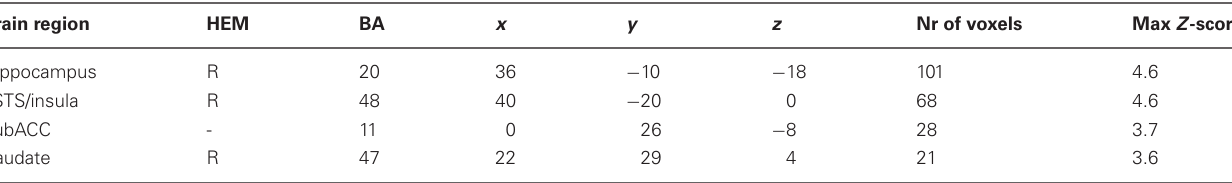
Table 1 | Significant areas of activation associated with conformity toward in-group members. Brain region